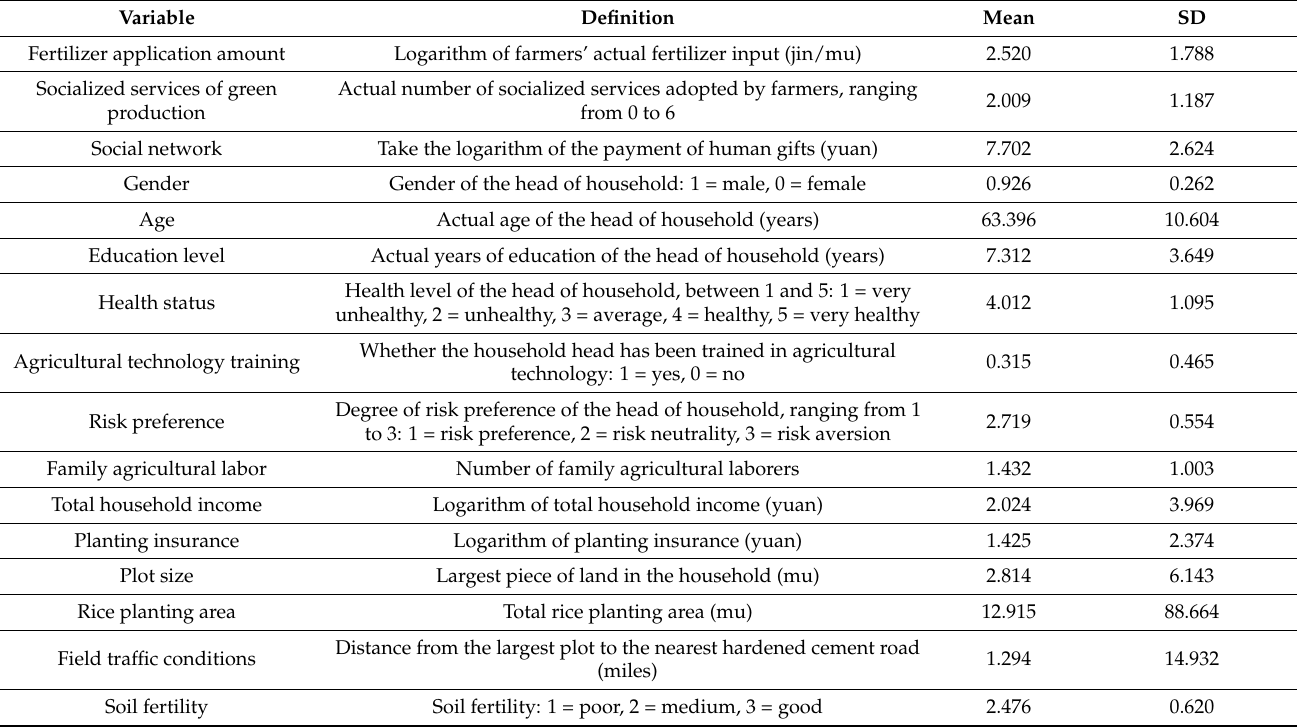
Table 1. Definitions and descriptive statistics of the survey